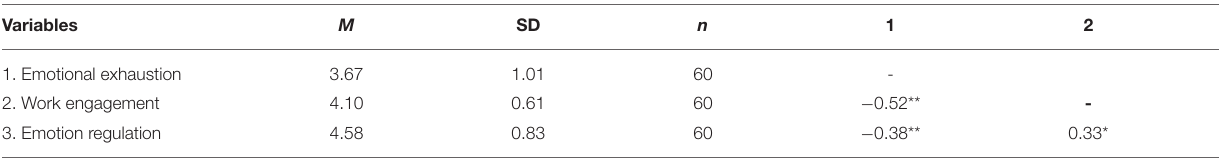
TABLE 5 | Descriptive statistics, and correlations coefficients for the study variables.